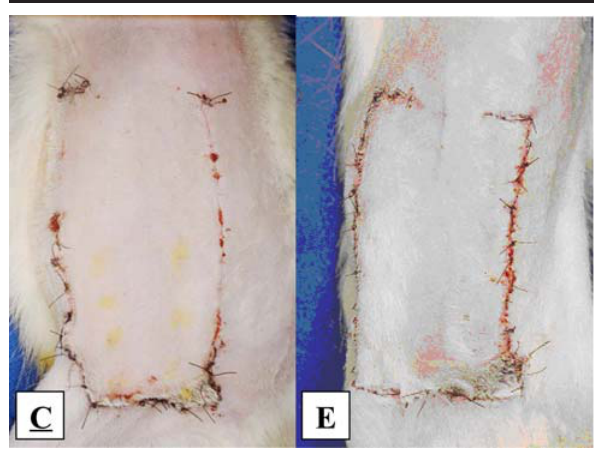
FIGURE 3 - Superior epigastric artery caliber increase in experiment group flap compared to control group. Necrosis area at inferior and medial portions of the flap. TABLE 1 - Mean flow in every of eight points in three different moments: preoperative,